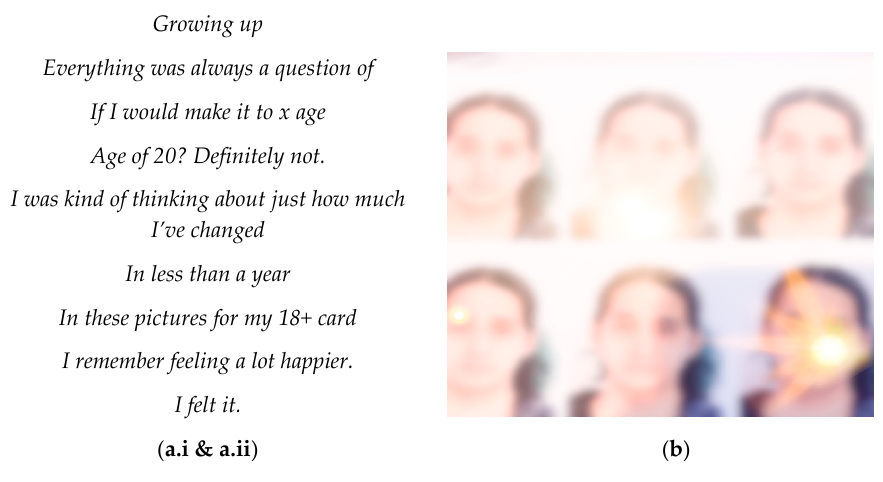
Figure 4. This figure depicts ( a.i ) Stanza 7 of the poem; ( a.ii ) Stanza 8 of the poem; ( b ) Images taken for an 18+ card (a New Zealand identity card).